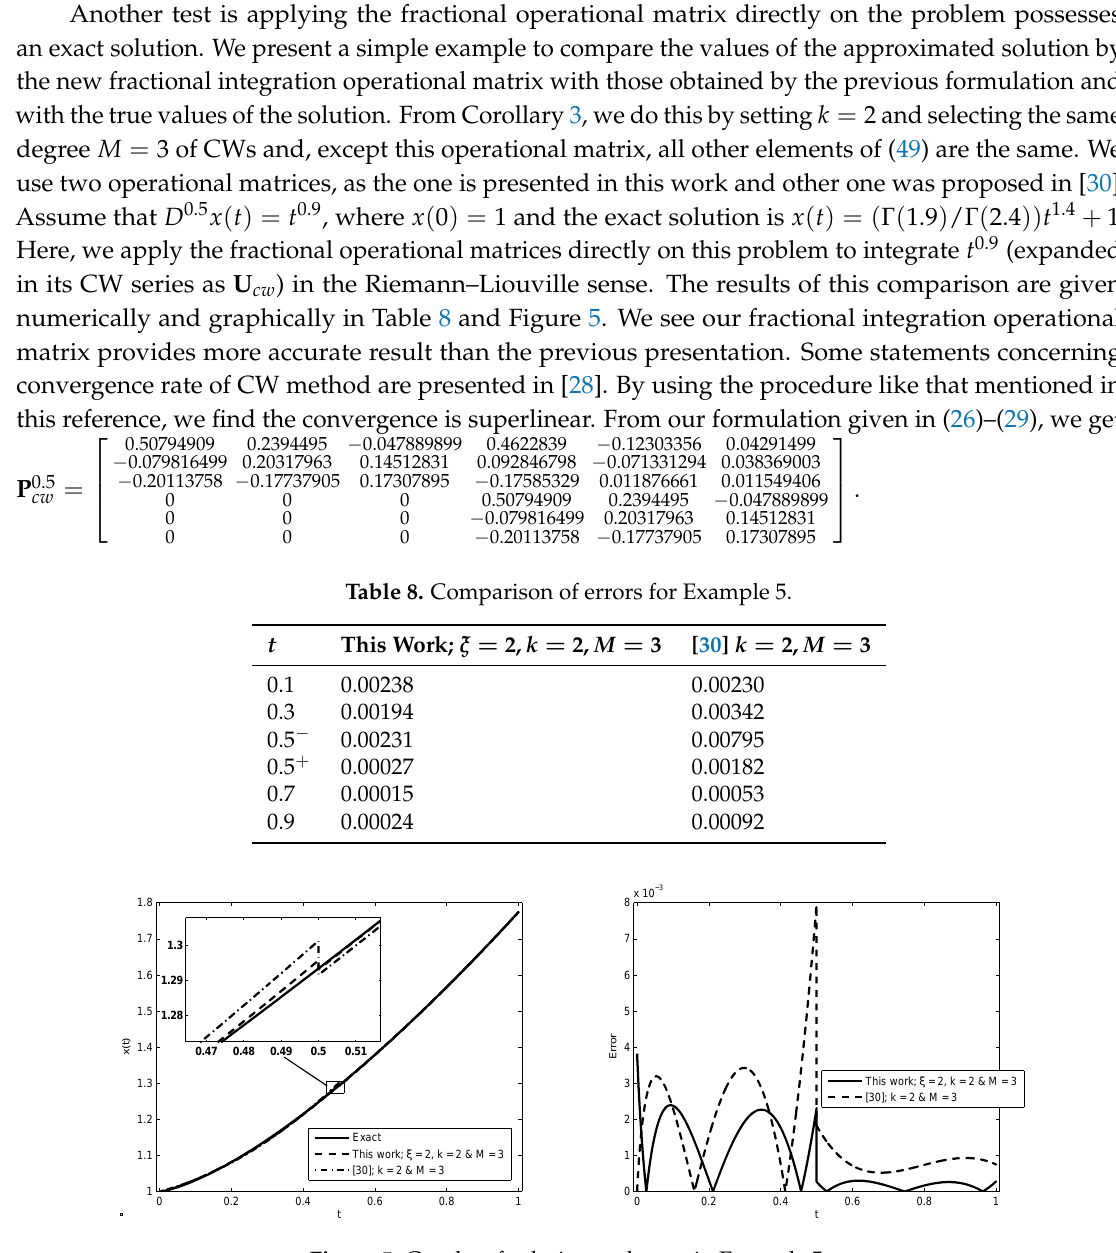
Figure 5. Graphs of solution and error in Example